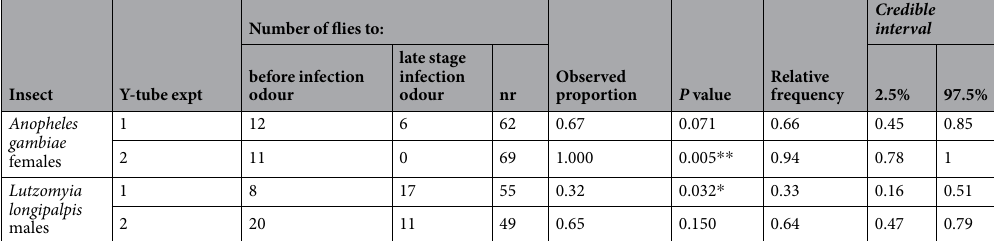
Table 3. Response of control insects, female Anopheles gambiae and male Lutzomyia longipalpis to odour of the before and late stage infected hamsters. Responses were compared by a binomial distribution exact test. Significant ( * P < 0.05, ** P < 0.01) attraction to late stage infected hamsters was found in one of the two runs but not in the other for each control insect. A Bayesian test of proportion shows that only A. gambiae in the second run has a frequency significantly larger than